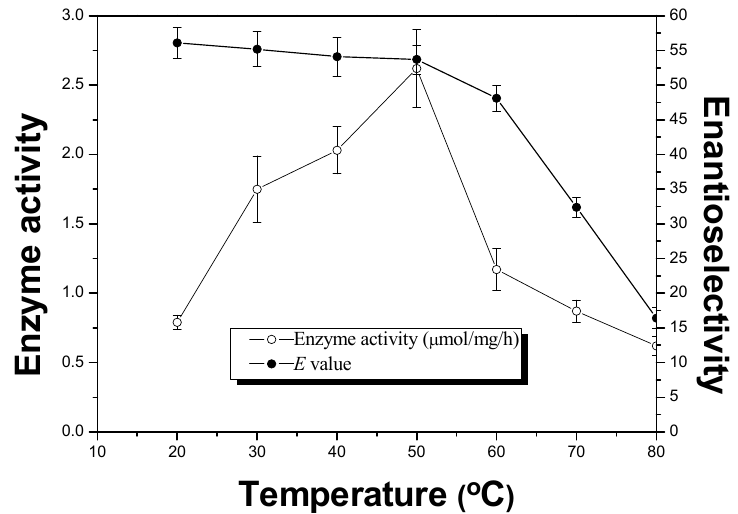
Figure 2. Effects of temperature on enzyme activity ( μ mol/mg/h, ○ ) and enantioselectivity ( E value, ● ) in the enzyme-catalyzed esterification of ibuprofen. The reactions were carried out in n -heptane (60 mL), ibuprofen (0.02 M) and 1-octanol (0.02 M) and APE 1547 (60 mg, pH 8.5). The mixture was incubated in the microwave oven (480W, 150 rpm) at different